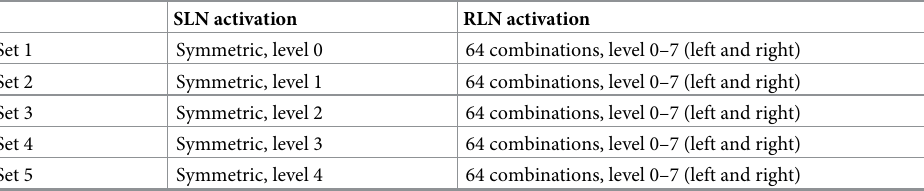
Table 1. Neuromuscular conditions